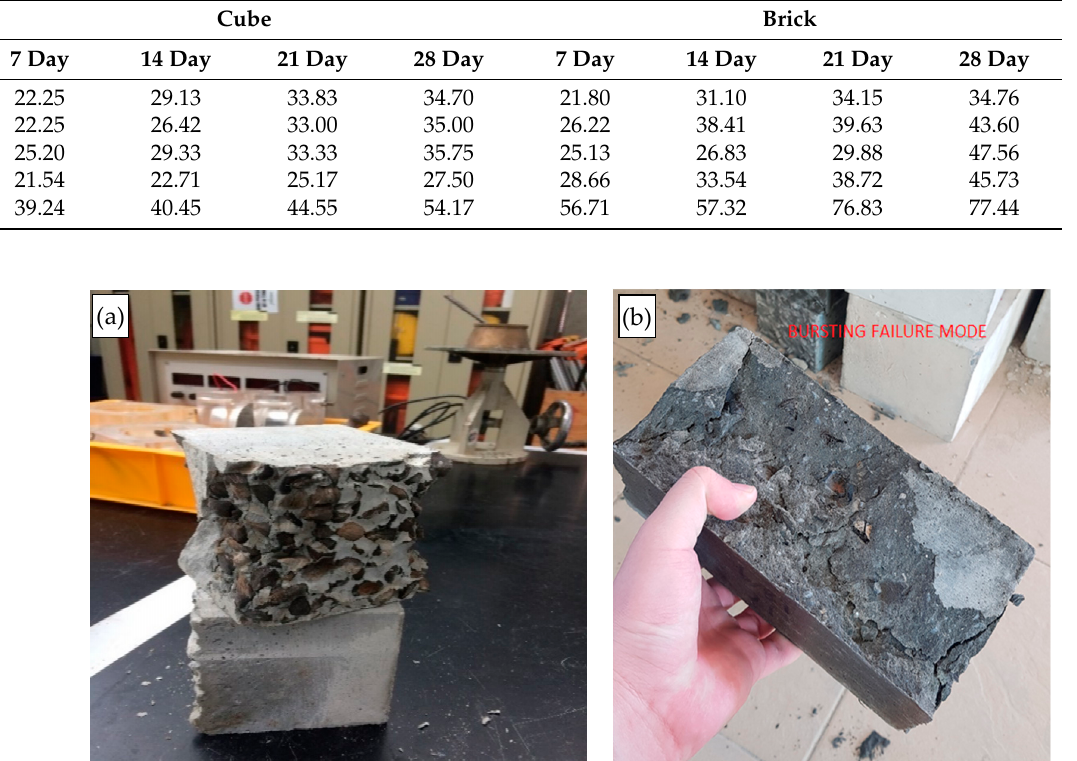
Figure 5. Typical failure modes of the design mixes for ( a ) cube and ( b ) brick specimens. Table 6. Strength at different concrete ages.